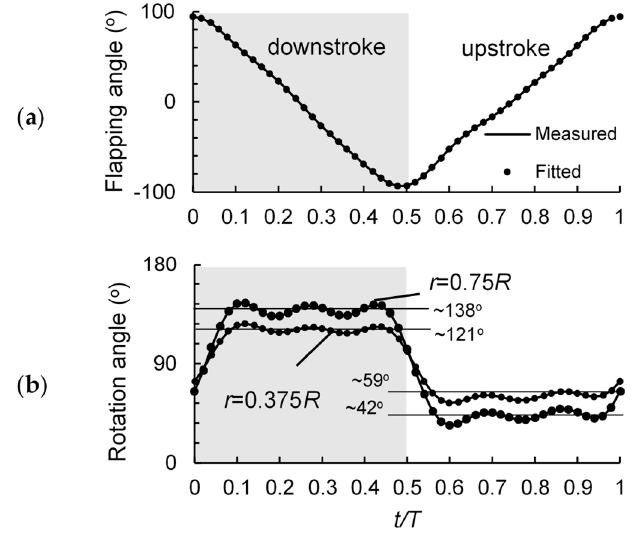
Figure 2. Wing kinematics of the KUBeetle: ( a ) flapping angle ( Φ ) and ( b ) rotation angle ( θ t ) at r = (0.375 and 0.75) R .